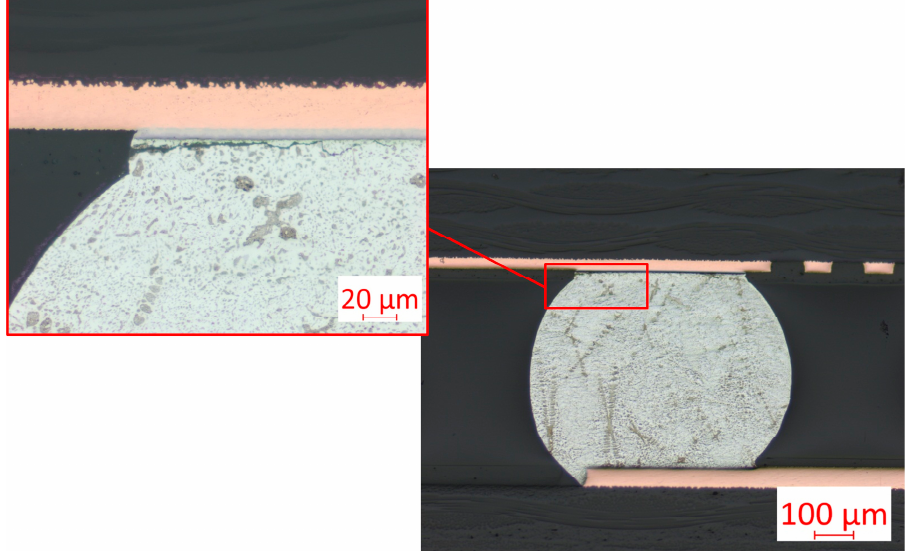
Figure 15. A SEM of failed solder joint for the random vibration tests in D101.